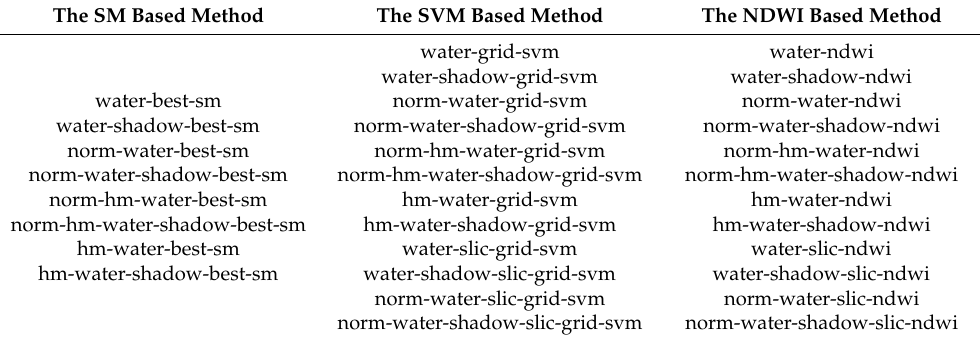
Table 4. List of experimental setups for analyzing overall performance of the three methods in comparison. The combination in the table is composed by components listed in Table 3. For example, norm-hm-water-shadow-best-sm indicates a customized SM-based method. The method is trained on water-shadow samples from the normalized D302 image and is tested on the normalized D302 image and the preprocessed D609 image. In the preprocessing, the D609 image is firstly normalized to the Sentinel-2 image, and then has its histogram matched to the normalized D302